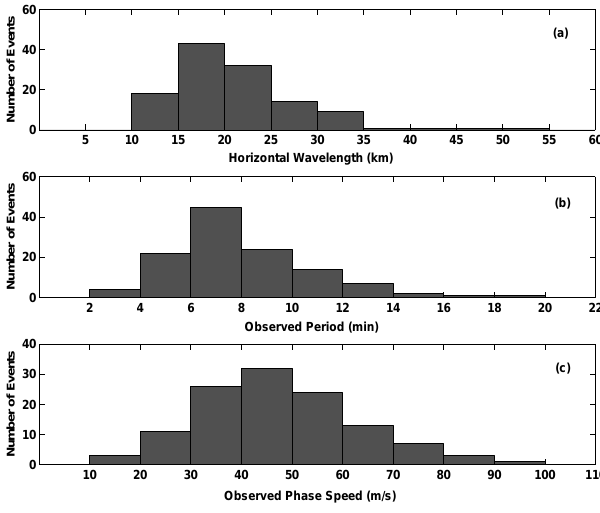
Fig. 4. Histograms of band parameters. (a) Horizontal wavelength, (b) observed wave period, (c) observed horizontal phase speed.